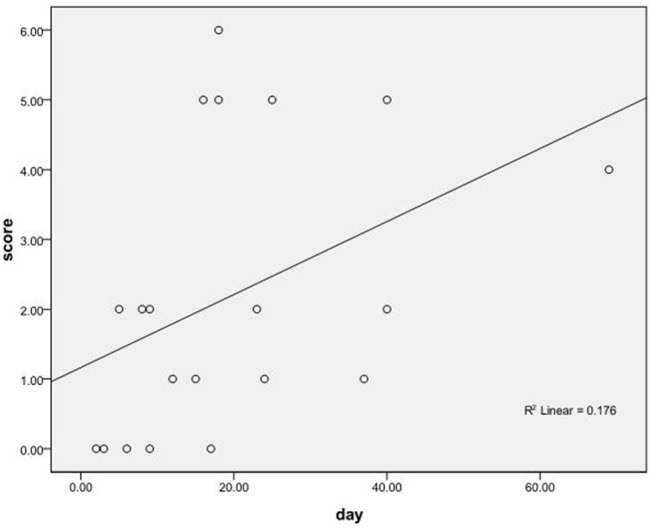
The correlation between the immunotherapy latency and the prognostic mRS scores of 20 patients who received immunotherapy.